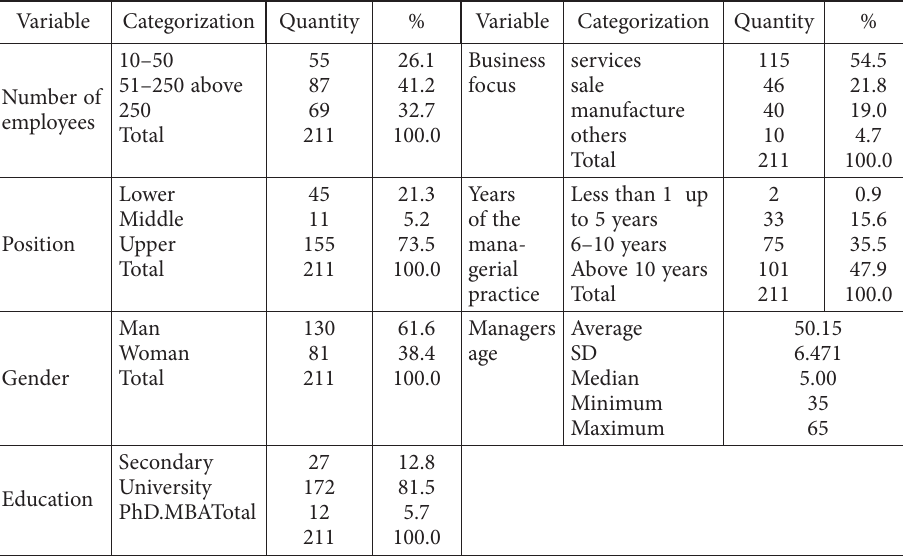
Table 2. The research sample (source: own research)